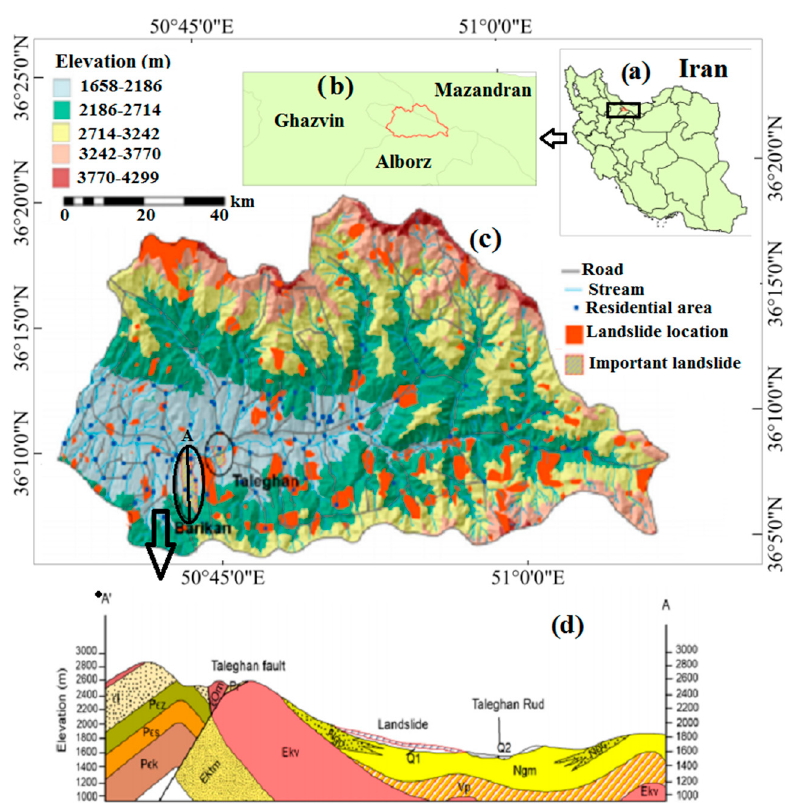
Figure 1. ( a ) Location of the study area in Iran, ( b ) location of the study area in Alborz and Mazandran provinces, ( c ) location of roads and Taleghan city in the study area, and ( d ) geological cross-section of the Barikan landslide.